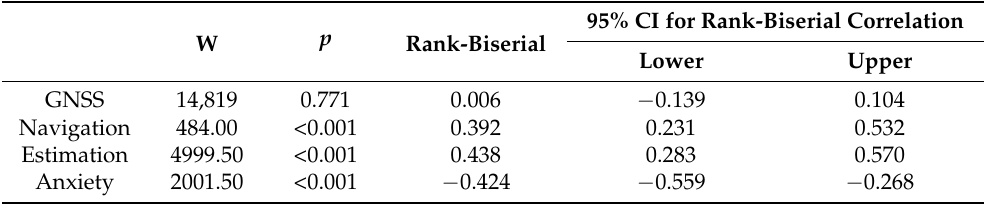
Table 1. Mann-Whitney U test employed to examine differences across gender, upper and lower CI, as well as the Rank-Biserial Correlation. Global navigation satellite systems = GNSS. 95% CI for Rank-Biserial Correlation W p Rank-Biserial Lower Upper GNSS 14,819 0.771 0.006 − 0.139 0.104 Navigation 484.00 <0.001 0.392